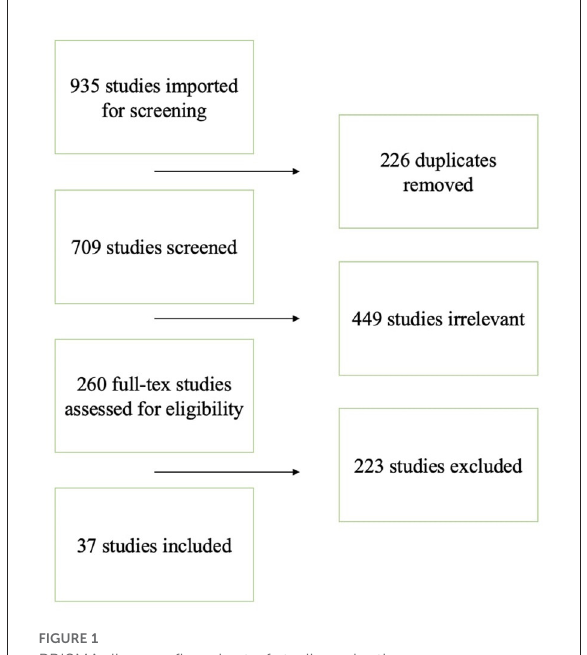
FIGURE1 PRISMA diagram flowchart of studies selection